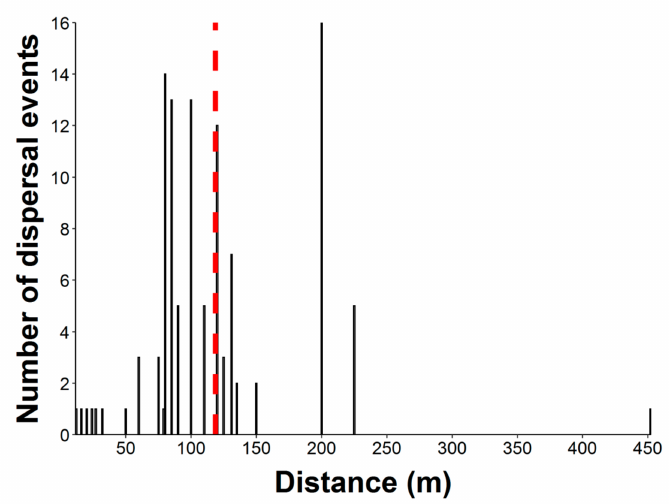
Figure 6. Distribution of seed dispersal distances (N = 112) recorded in 17 parrot species. Red dashed line shows the mean value of seed dispersal